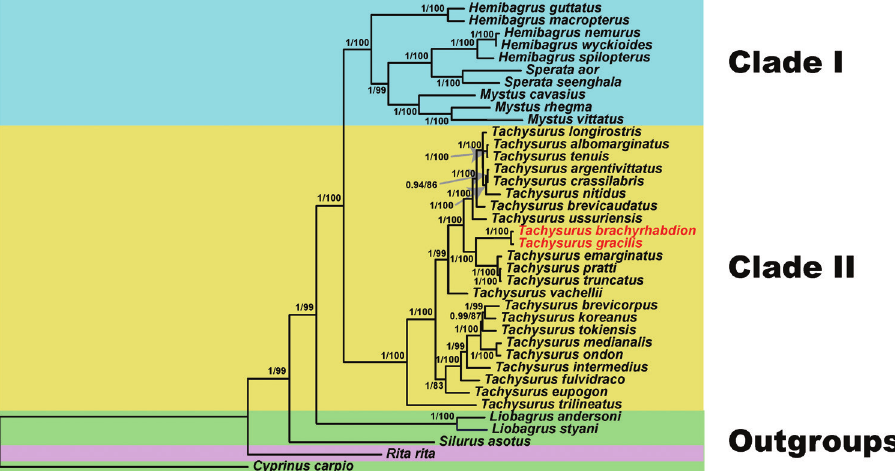
Figure 4. Phylogenetic tree obtained from BI and ML analysis based on the 13 PCGs dataset. The numbers at the nodes separated by “/” indicate the posterior probability (BI) and bootstrap value